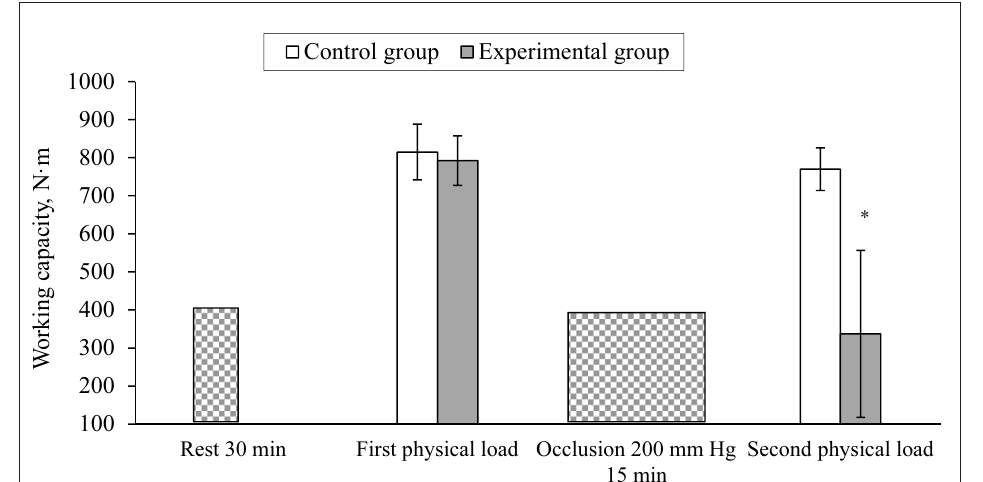
Figure 2. Changes of working capacity in